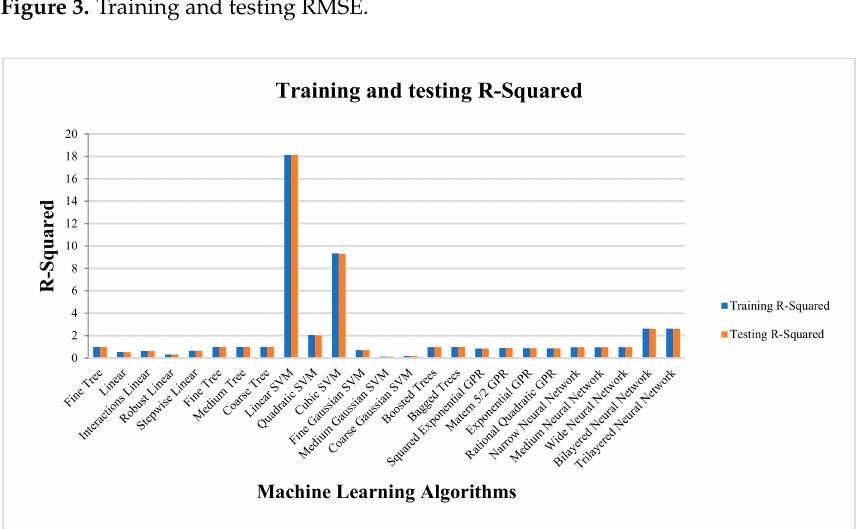
Figure 3. Training and testing RMSE.